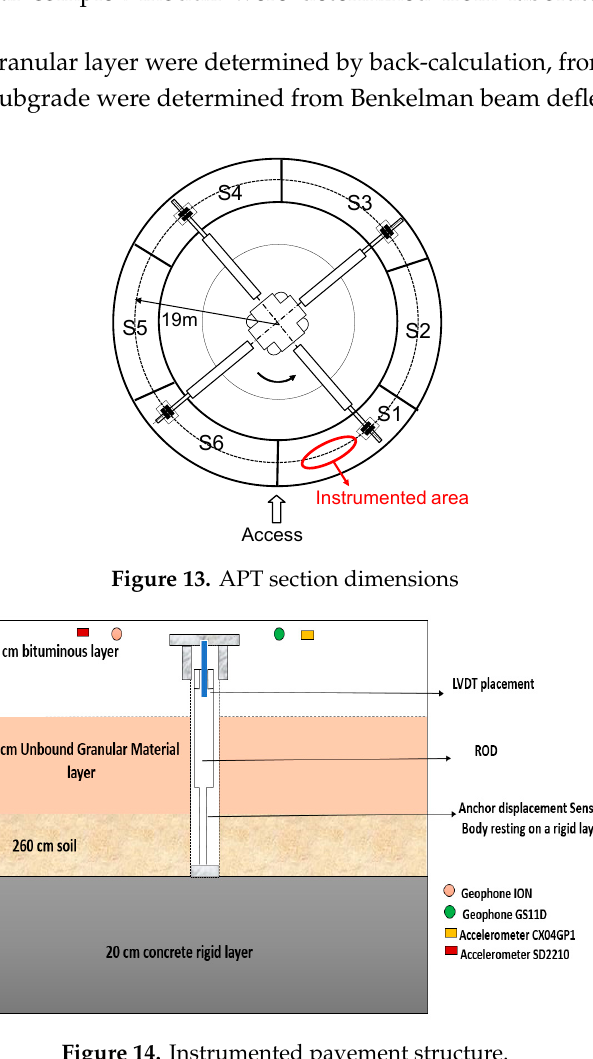
Figure 14. Instrumented pavement structure. Table 2. Characteristics of the pavement